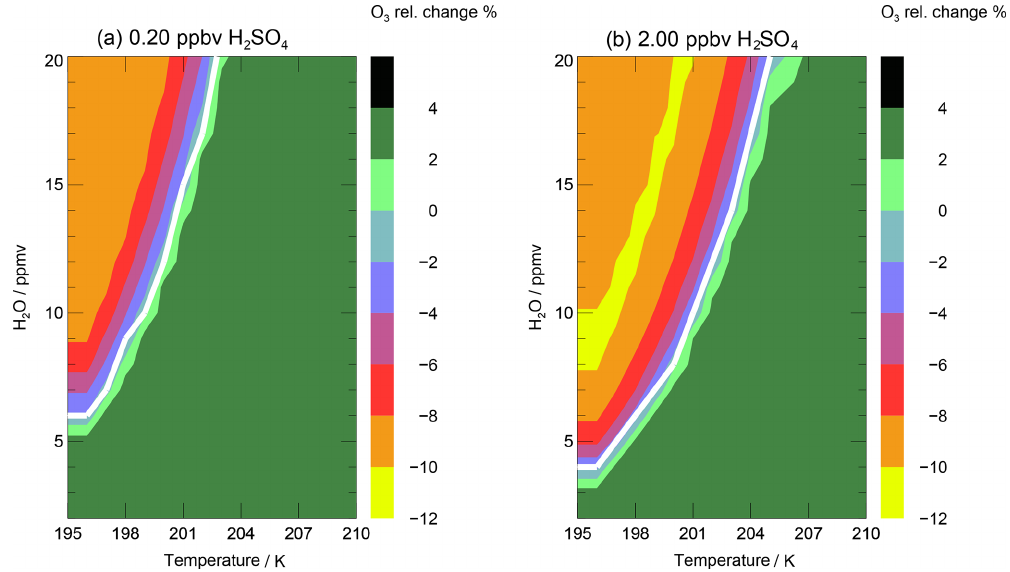
Figure 9. Relative ozone change during the 7d simulation along the standard trajectory dependent on temperature and H 2 O ratio for climato- logical non-enhanced (a) and enhanced (b) sulfate conditions. The white line corresponds to the water- and temperature-dependent chlorine activation